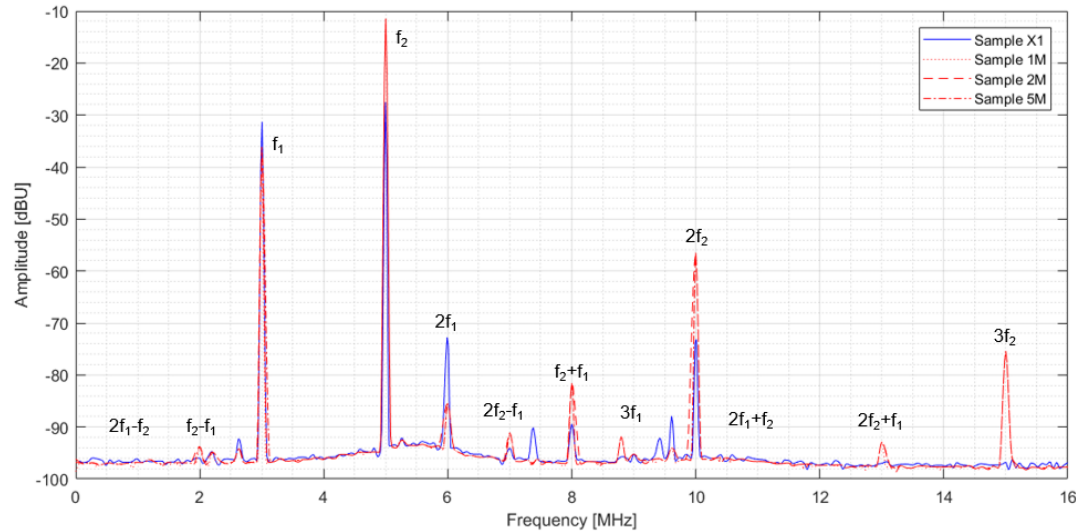
Figure 11. Comparison of frequency spectrum: f 1 = 3 MHz, f 2 = 5 MHz, α = 60°.